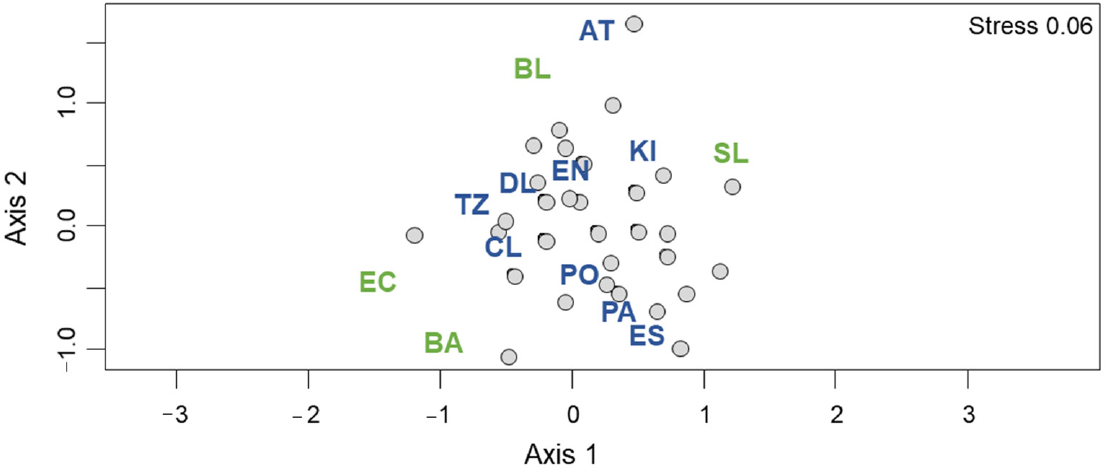
Figure 2. Non-metric MDS of the species distribution among the Lakes of Montebello. Lakes’ abbreviations are as in Table 1: Green, eutrophic lakes; blue, oligotrophic lakes. Table 3. Species that contributed the most to dissimilarity among the Lakes of Montebello during the mixing and stratification seasons. Contribution to Cumulative Taxa Season Lakes Dissimilarity (%) Contribution (%) Procladius sp. 3.18 3.18 AT, EN, TZ Amphipoda genus 1 2.47 5.65 EN, TZ Ballistura libra 2.47 8.13 BA, TZ Harnischia sp. 2.47 10.60 DL, ES Homochaeta sp. 2.47 13.07 BA, TZ Stratification Chironomidae genus 1 2.47 15.55 DL, EN Polypedilum sp. 2.47 18.02 DL, EN Probezzia sp. 2.47 20.49 DL, EN Chaoborus sp. 2.47 22.97 PO, TZ Lepidocyrtus lanuginosus 2.47 25.44 BA, TZ Sminthurides sp. Microchironomus sp. Homochaeta sp. Rheotanytarsus sp. Procladius sp. Chaoborus sp. Mixing Procladius sp. Limnodrilus sp. Naididae genus 1 Koenikea sp. Polypedilum sp. The bio-env test showed consistent results for all three beta diversity components at each season (Table 4). The beta diversity components were correlated to